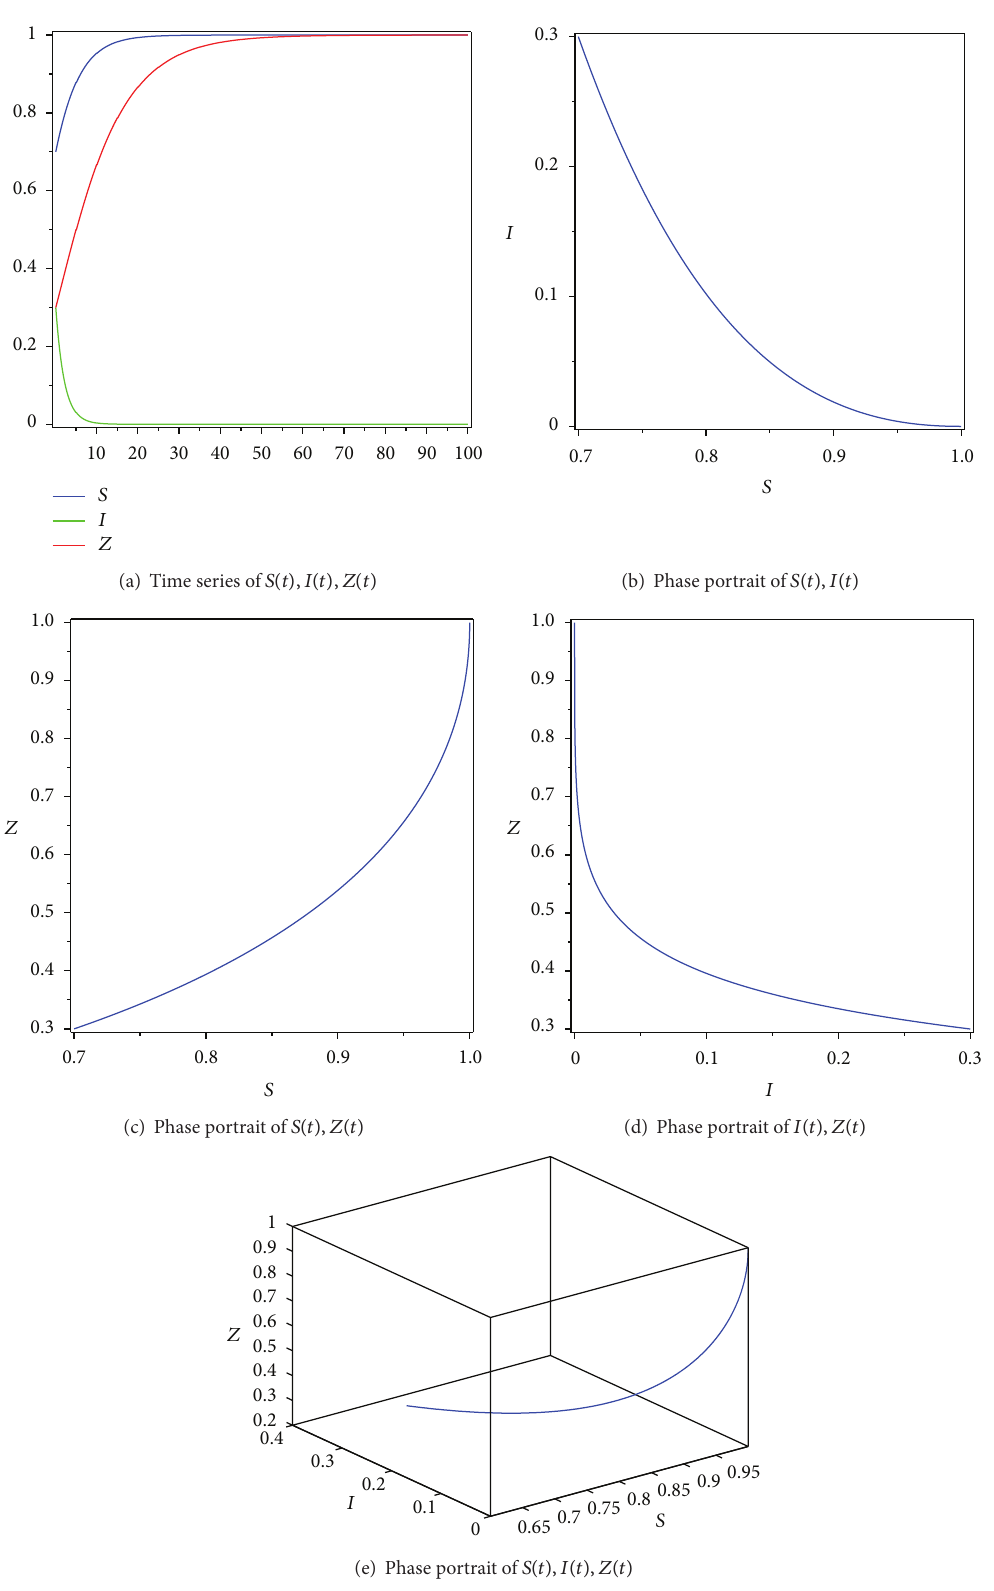
Figure 1: Illustration of basic behavior of system (7) on the threshold values 𝑅 = 0.2 < 1 , where Λ = 0.2, 𝜇 = 0.2, 𝛽 = 0.1, 𝑟 = 0.3, 𝑎 = 0.1 , the initial value is (𝑆 0 ,𝐼 0 ,𝑍 0 ) = (0.7, 0.3, 0.3) , and 𝐸 0 = (1, 0,1)